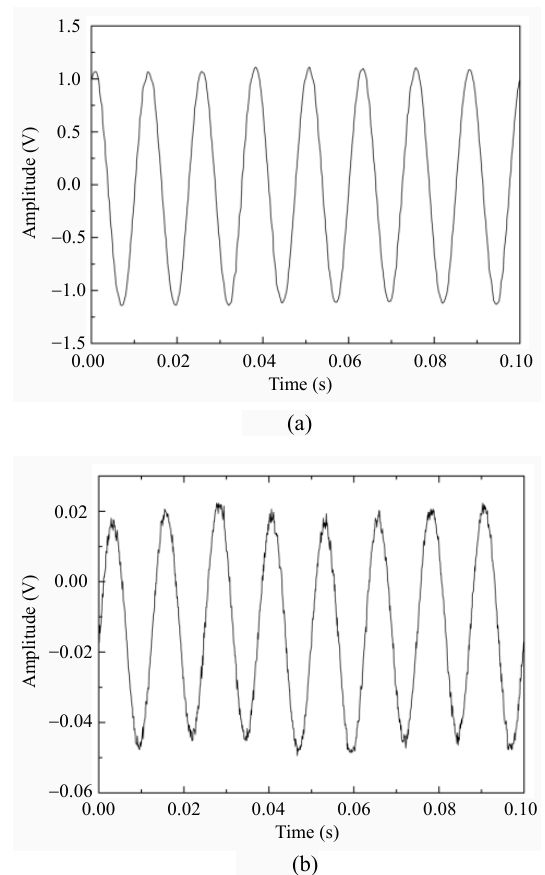
Fig. 8 Demodulated vibration signals by (a) fiber sensor and (b) SGO-15HT.